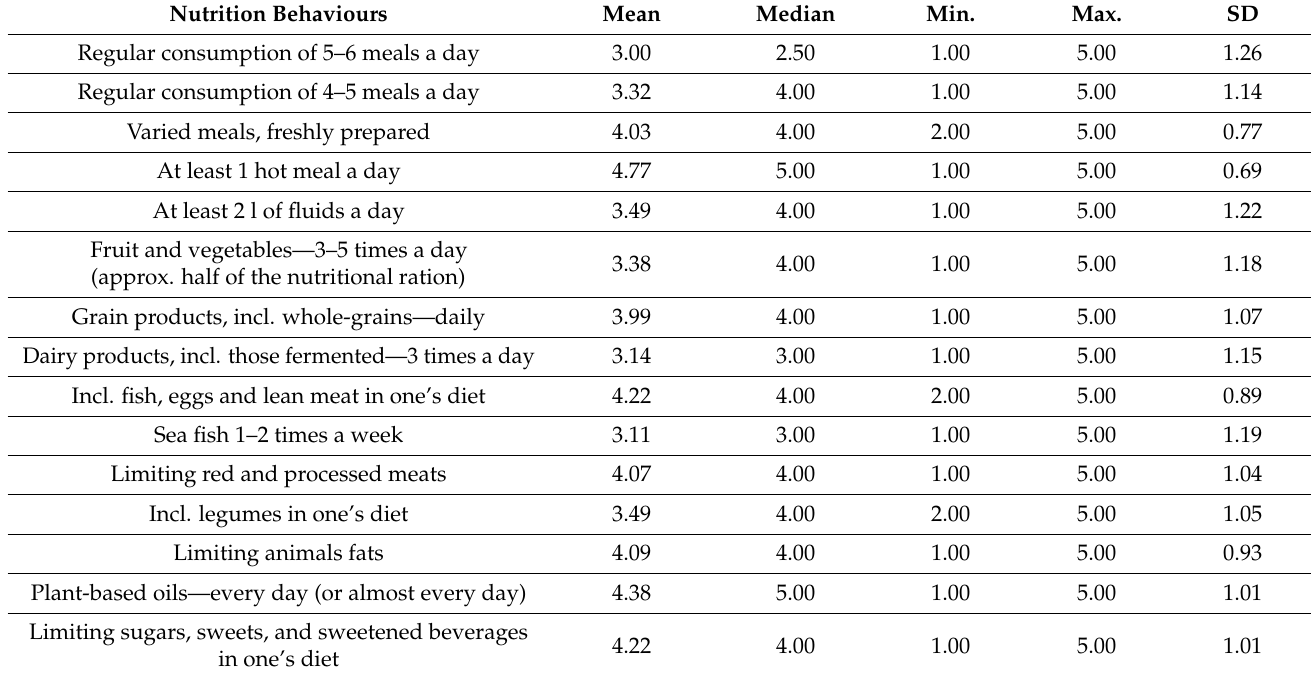
Table 1. Level of rational nutrition behaviours among women participating in the “Healthy Active Senior” programme (N = 120) (descriptive